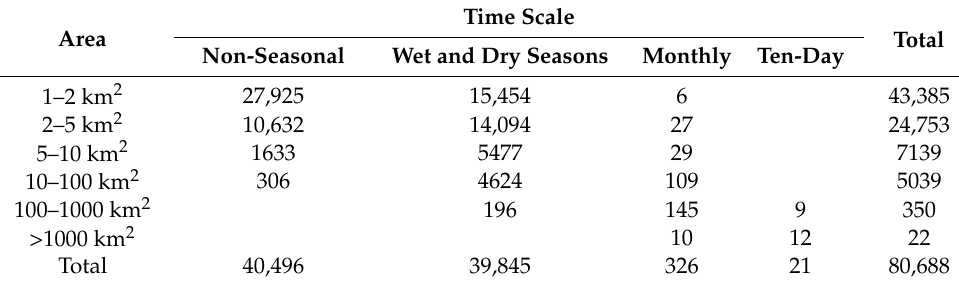
Table 2. Seasonal observation of lakes of different